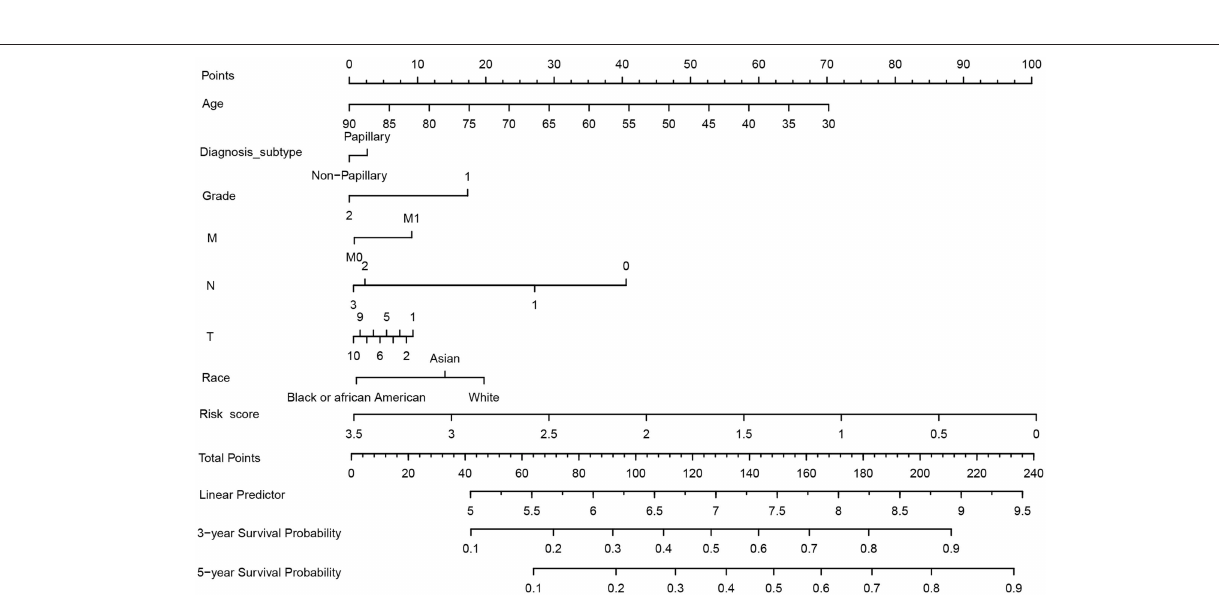
Frontiers in Oncology |